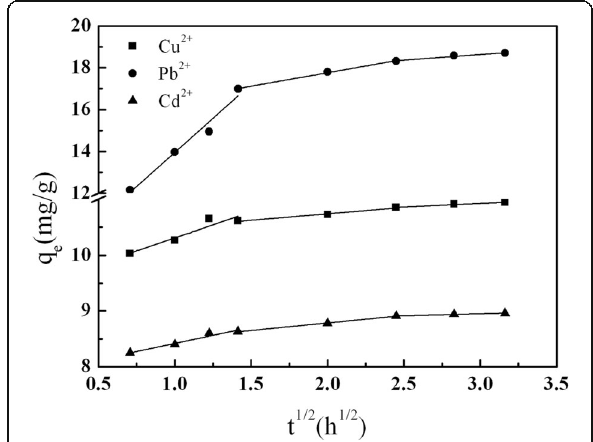
Additional file 1: Figure S1. schematic diagram of the dissolution of silica fume. Table S1. Purification rate of silica fume. Figure S2. the N 2 adsorption – desorption isotherm of the sample prepared with HCl at room temperature within 24 h. Table S2. Textural properties of the sample Table S3. Fitting parameters of Langmuir and Freundlich isotherms for the adsorption of Cu 2+ , Pb 2+ , and Cd 2+ on c-MCM-41(40). Figure S5. The kin- etics of Cu 2+ , Pb 2+ , and Cd 2+ adsorption on c-MCM-41(40). Figure S6. Plot of kinetic model for the adsorption of Cu 2+ , Pb 2+ , and Cd 2+ , (A) pseudo-first- order kinetic model (B) pseudo-second-order kinetic model. (DOCX 1066 kb)